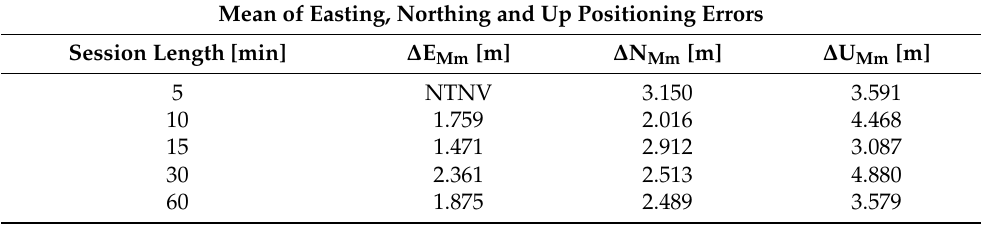
Table 8. Mean of Easting, Northing and Up DGNSS positioning errors for ∆ E Mm , ∆ N Mm , ∆ U Mm .